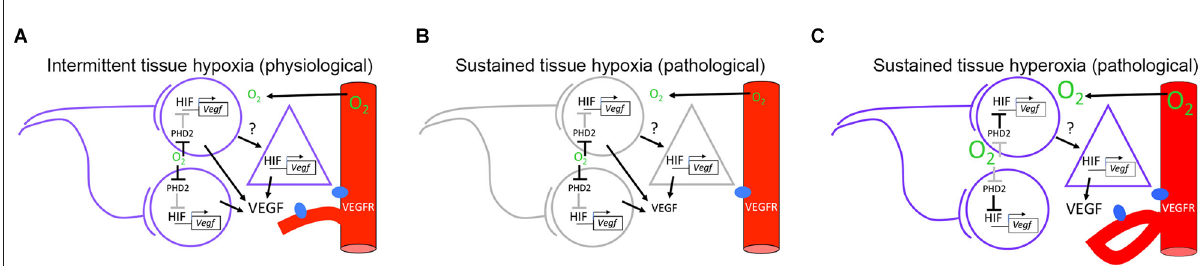
FIGURE1 Hypothetical model for neuronal activity modulation of angiogenesis in neonate rodents. (A) Under environmental normoxic conditions, co-active neurons contribute to generate an intermittent hypoxic environment that favors proangiogenic signaling through the HIF/VEGF pathway. Neuron to astrocyte communication may contribute to VEGF production through unidentified signals. (B) Under environmental hypoxic conditions, a sustained hypoxic environment is imposed in the brain parenchyma. Sustained hypoxia inhibits electrical activity in neurons and potentially, signaling from neurons to astrocytes. Despite favorable conditions for HIF/VEGF signaling, VEGF levels are reduced resulting in a decrease in the angiogenic response. (C) Under environmental hyperoxic conditions, a sustained hyperoxic environment is imposed on the brain parenchyma. Sustained hyperoxia is favorable for neuronal activity but not for HIF/VEGF signaling in neurons. Altered VEGF release and aberrant angiogenic responses are hypothesized to originate from abnormal neuron to astrocyte signaling. Circles represent neurons. Triangles represent astrocytes. Red cylinders represent blood vessels expressing VEGF receptors (VEGFR), shown in blue. Active cells and pathways are shown in purple and black, respectively. Inactive cells and pathways are shown in gray. HIF/VEGF signaling pathway has been adapted from Leu et al. (2019). HIF, hypoxia inducible transcription factor; VEGF, vascular endothelial growth